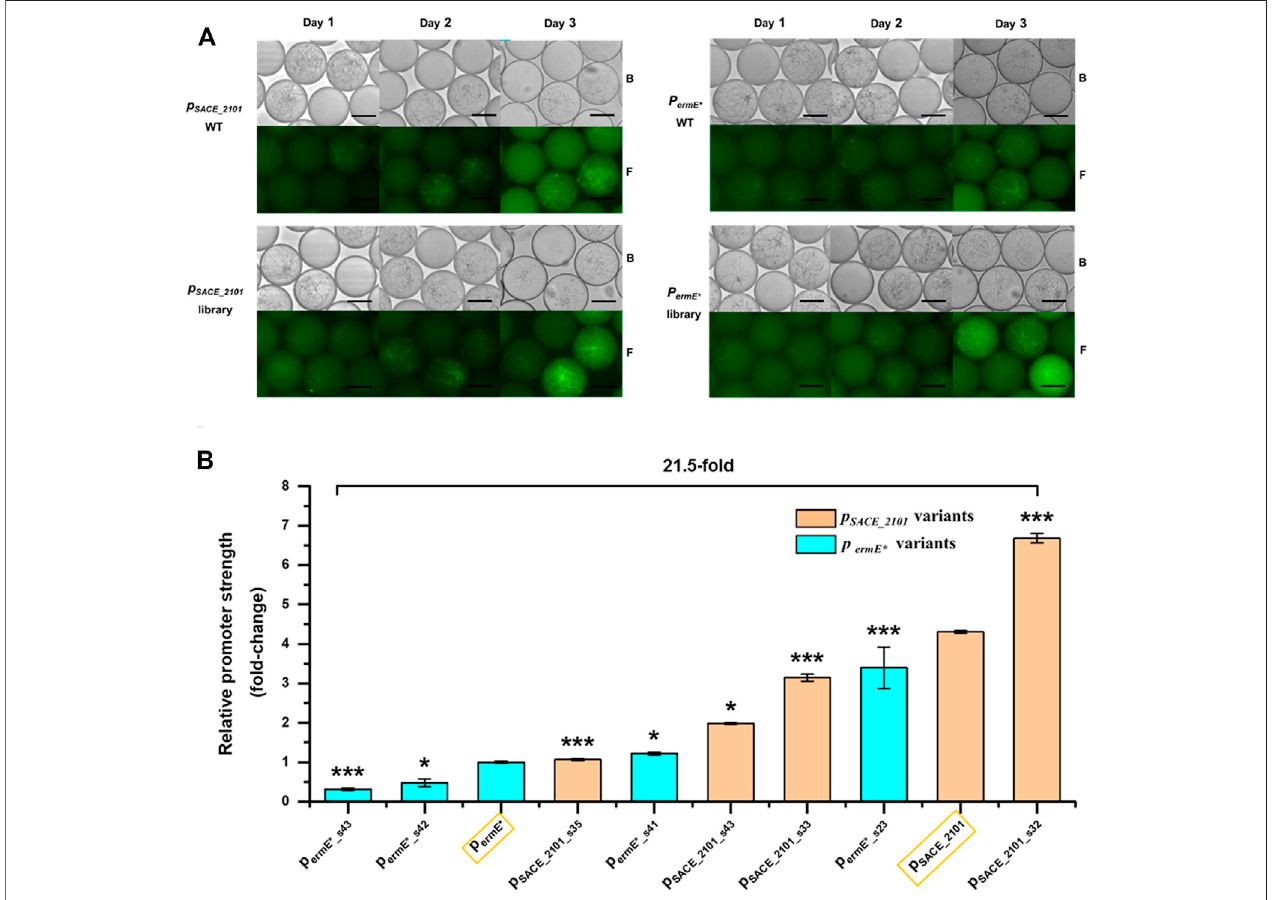
FIGURE3| PromoterscreeningbyFADS. (A) Fluorescencemicroscopyofdropletscontainingwild-typestains( p SACE_2101 WT, p ermE* WT)andvariants( p SACE_2101 library, p ermE* library) at different time intervals. B: Bright fi eld. F: Fluorescence. Scale bar: 50 μ m. (B) Relative strengths of the screened promoter variants in libraries SACE_2101 (lib) ( p SACE_2101 library) and ermE*(lib) ( p ermE* library) compared to their corresponding WTs (Surrounded by yellow frames). Error bars represented the standard deviation of three biological samples. * p ≤ 0.05 and *** p ≤ 0.001 (Student ’ s two-tailed t